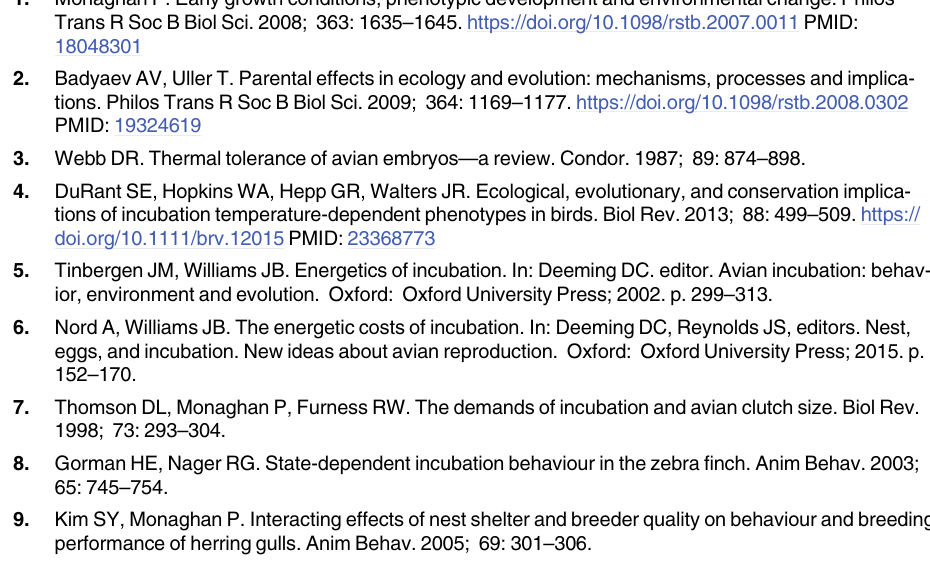
S2 Table. Whole-body BMR measured at four different ages. S3 Table. Biometric measurements of birds belonging to the three experimental treatment groups. S4 Table. Blood oxidative status at age 45 and